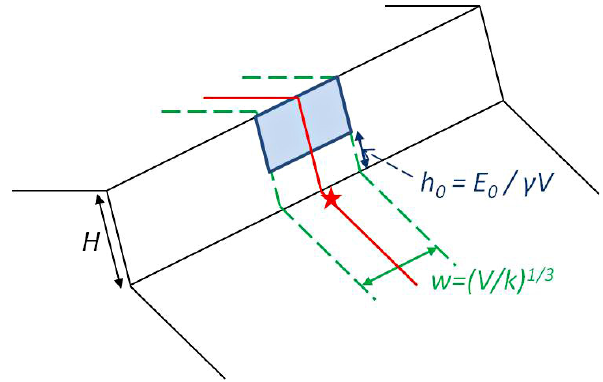
Fig. 3. Cylindrical slope with a punctual element at risk (star). The solid rectangle represents the wall area to be considered for a rock volume V to have a minimal potential energy E 0 . γ : the specific weight of the rock; k : shape